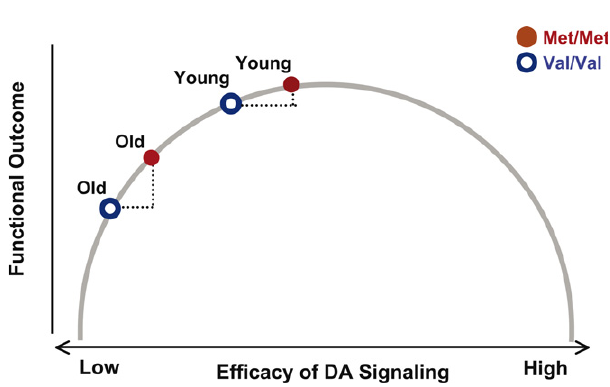
Figure 1. Inverted U-shaped function linking the effi cacy of frontal DA signaling in early versus late adulthood to performance. The shape of the curve implies that the difference in performance between older Met and Val carriers is greater than the difference between younger Met and Val carriers of the COMT